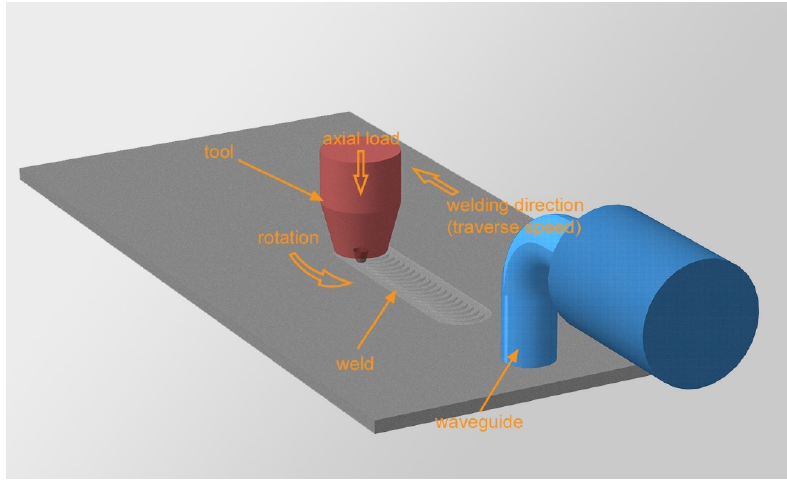
Figure 2. Friction stir welding